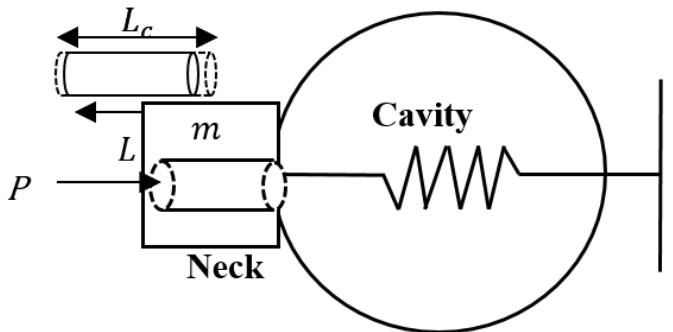
Figure 1. Geometry of Helmholtz resonator.